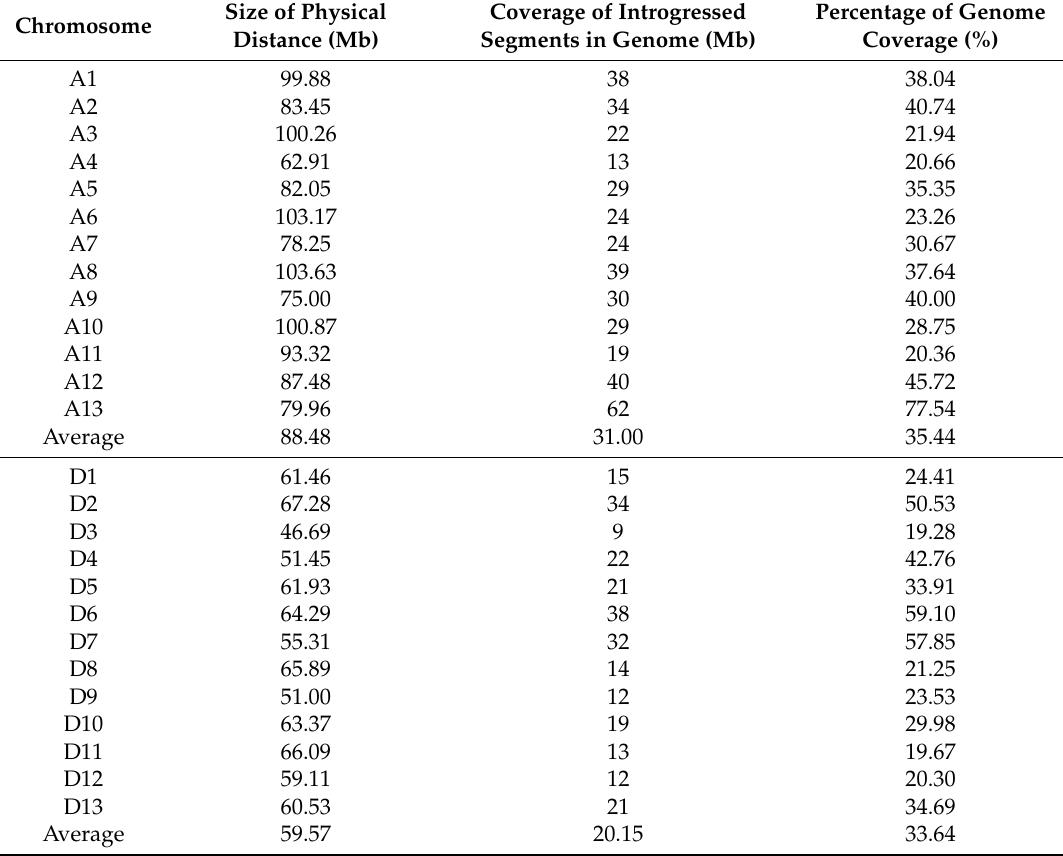
Table 3. Genome coverage of introgressed chromosome segments in